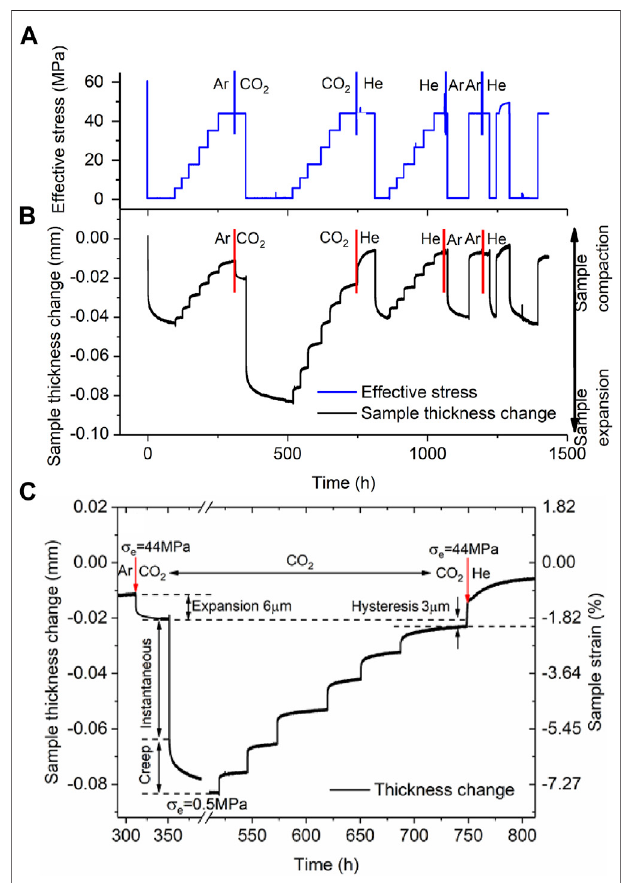
FIGURE3| Stresscyclingandassociatedsamplethicknesschangeand strain data collected from the Stage 2 runs performed on the AD Ca-SAz-1 sample using “ wet ” CO 2 , Ar and He pore fl uids. Similar data was obtained for the AD SWy-1 sample tested with wet He and CO 2 . (A) Stress path employed in Stage 2 tests on AD SAz-1 sample, sequentially charged with “ wet ” Ar, CO 2 , He, Ar and He at a pressure of 10 MPa. (B) Sample thickness change (relative to the starting point of the cycling series) as a function of experimental time. (C) Enlargement from (B) Sample thickness change and strain response to stress cycling in the presence of wet CO 2 . The moments at which the pore fl uid composition was switched are indicated with vertical